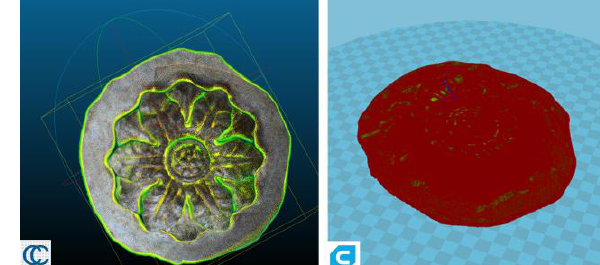
Figure 15. Creating mesh into Cloud Compare and check into